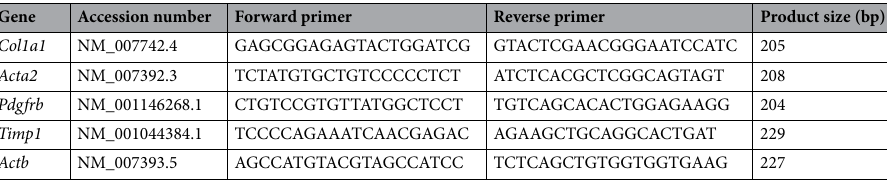
Table 1. Primers used for RT-PCR nucleotide